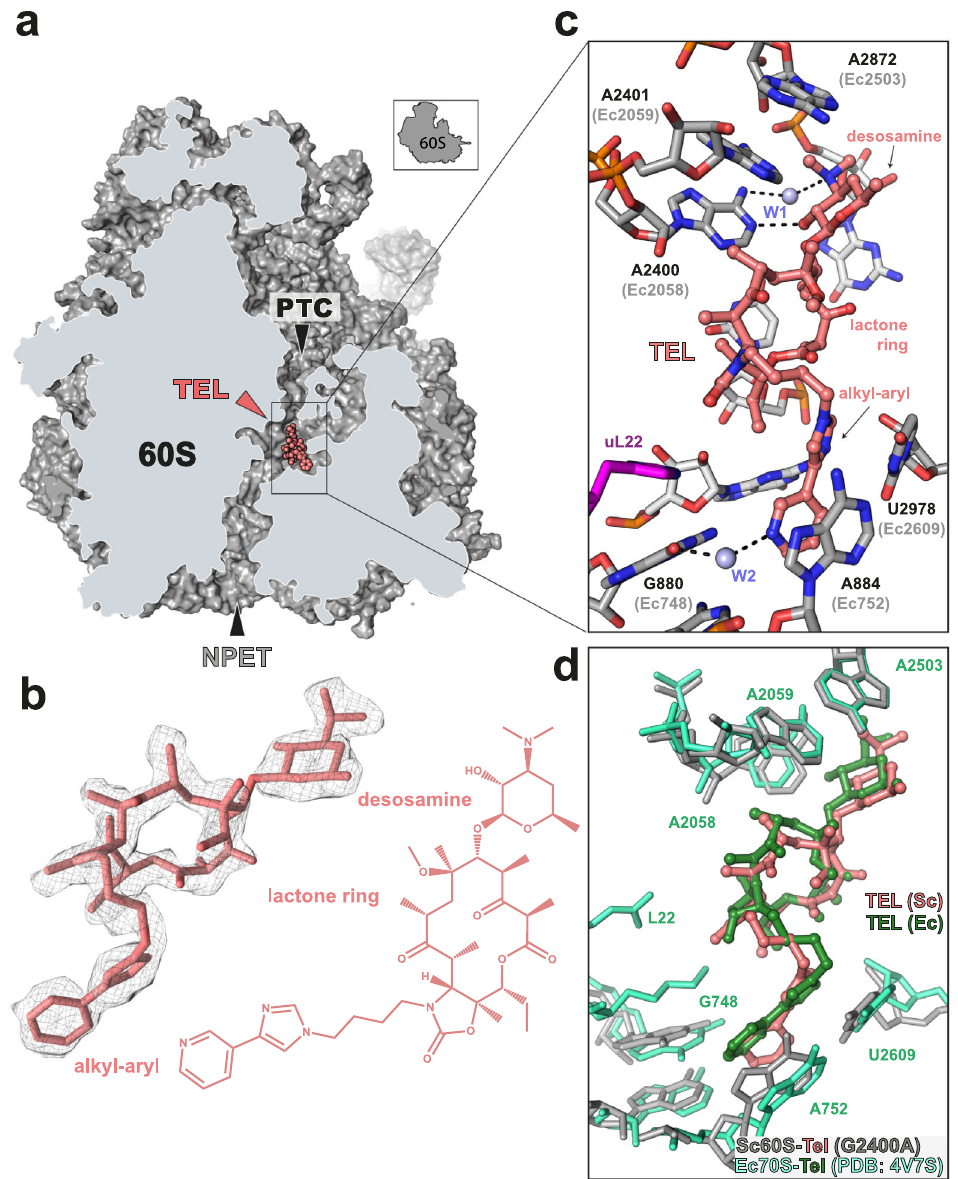
Fig. 3 Cryo-EM structure of TEL bound to the yeast ribosome. a Transverse section of the cryo-EM map density (gray) of the large (60S) subunit of the yeast G2400A mutant ribosome with TEL (salmon) bound within the NPET. b Isolated cryo-EM density for TEL (gray mesh) with fi tted molecular model for TEL. The similarly-oriented chemical structure of TEL is shown for reference. c TEL bound within the NPET with the surrounding nucleotides of the 25S rRNA (gray) and His133 residue of uL22 protein (purple). The N1 of A2400(A2058) forms a hydrogen bond interaction to the hydroxyl group of the desosamine sugar of TEL and a water molecule (W1) mediates interaction of the desosamine ’ s dimethylamine with the N6 of A2400(A2058), as was also observed in bacteria 43 . The alkyl – aryl sidechain of TEL stacks upon the base pair A884(A752)-U2978(U2609) and forms bridging interaction with water W2 (light blue) and O6 of G880(G748). d Superposition of TEL bound to the E. coli ribosome (green, PDB ID 4V7S 15 ) with TEL (salmon) in complex with the S. cerevisiae 60S subunit (Sc60S) bearing the G2400A mutation. E. coli rRNA and ribosomal protein residues are light green, yeast rRNA and protein residues are